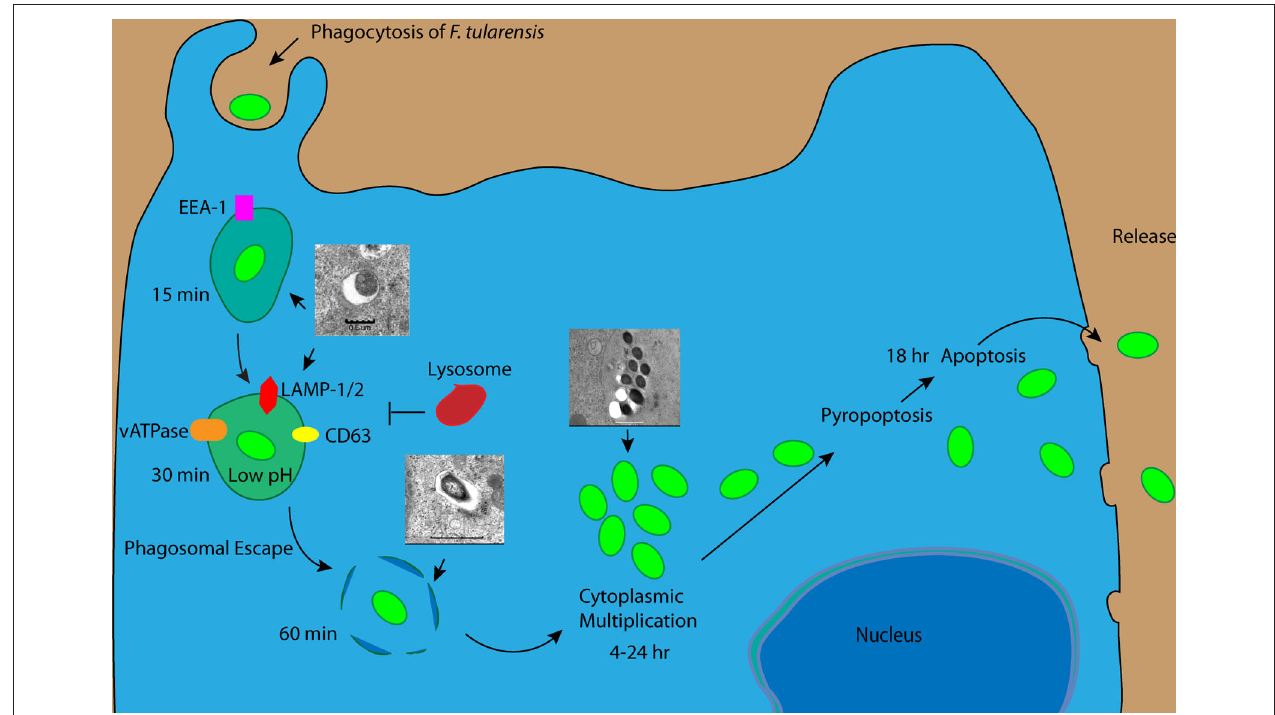
FIguRe 1 | Intracellular trafficking of Francisella tularensis within macrophages. F. tularensis enters macrophages using different receptors